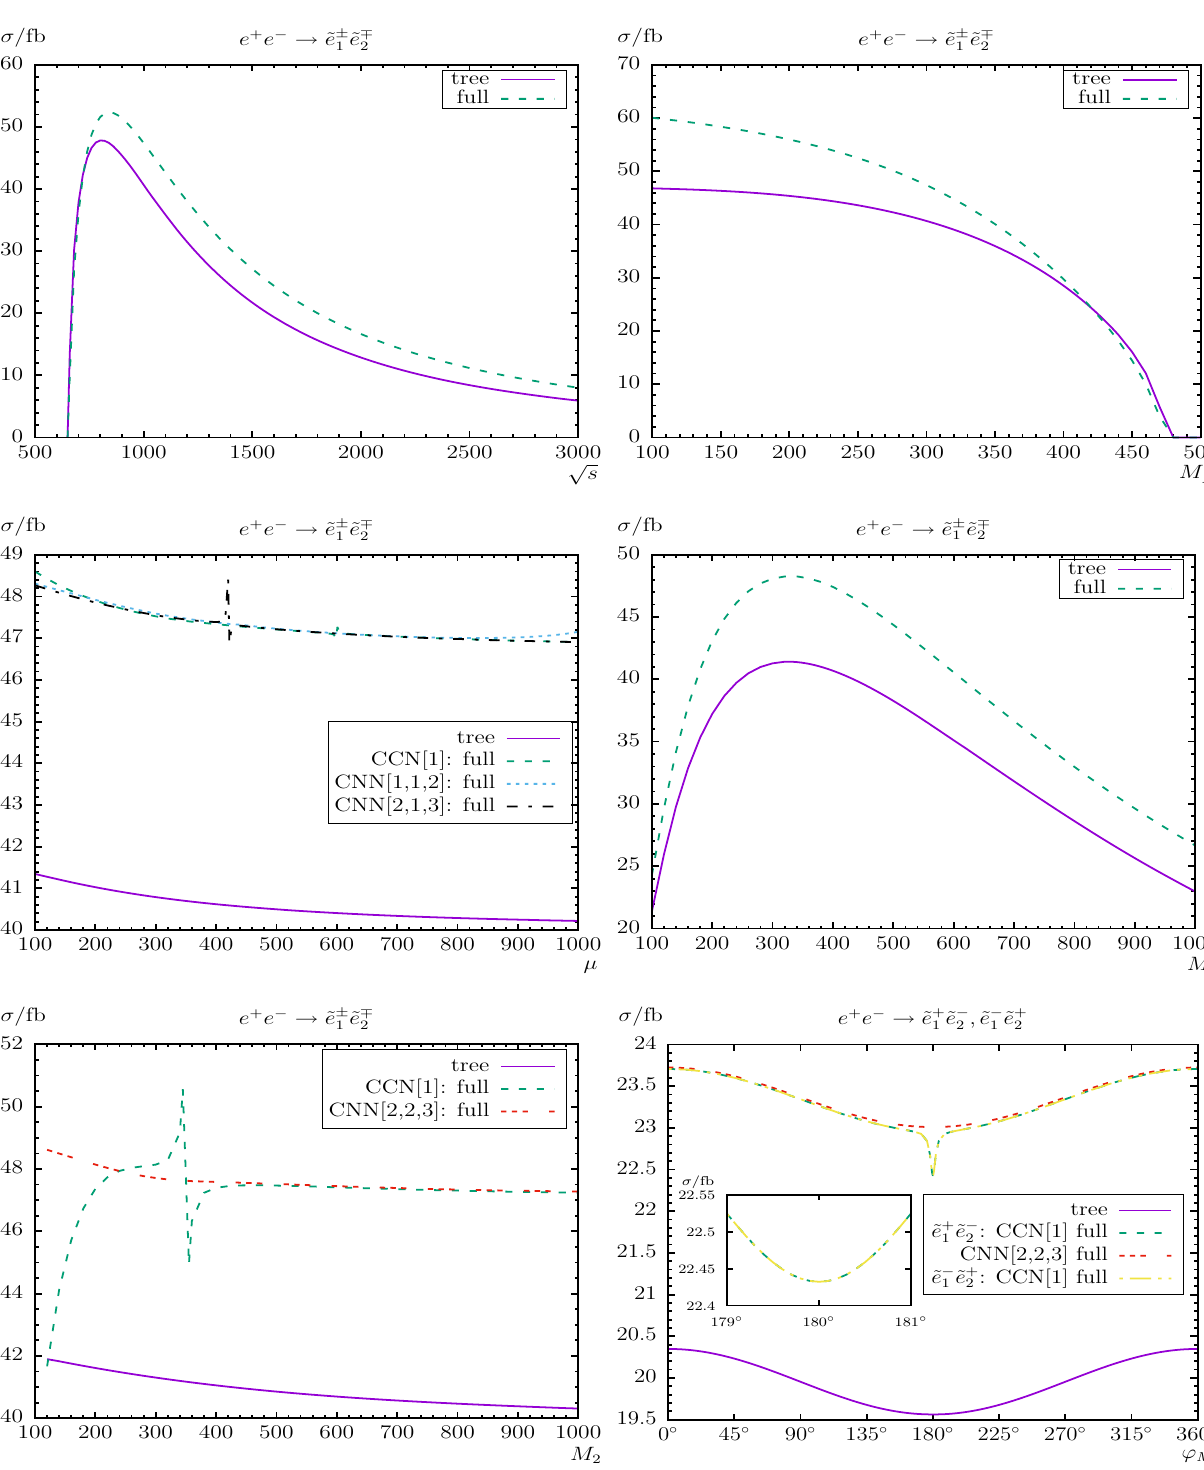
(right) varied. All masses and 1